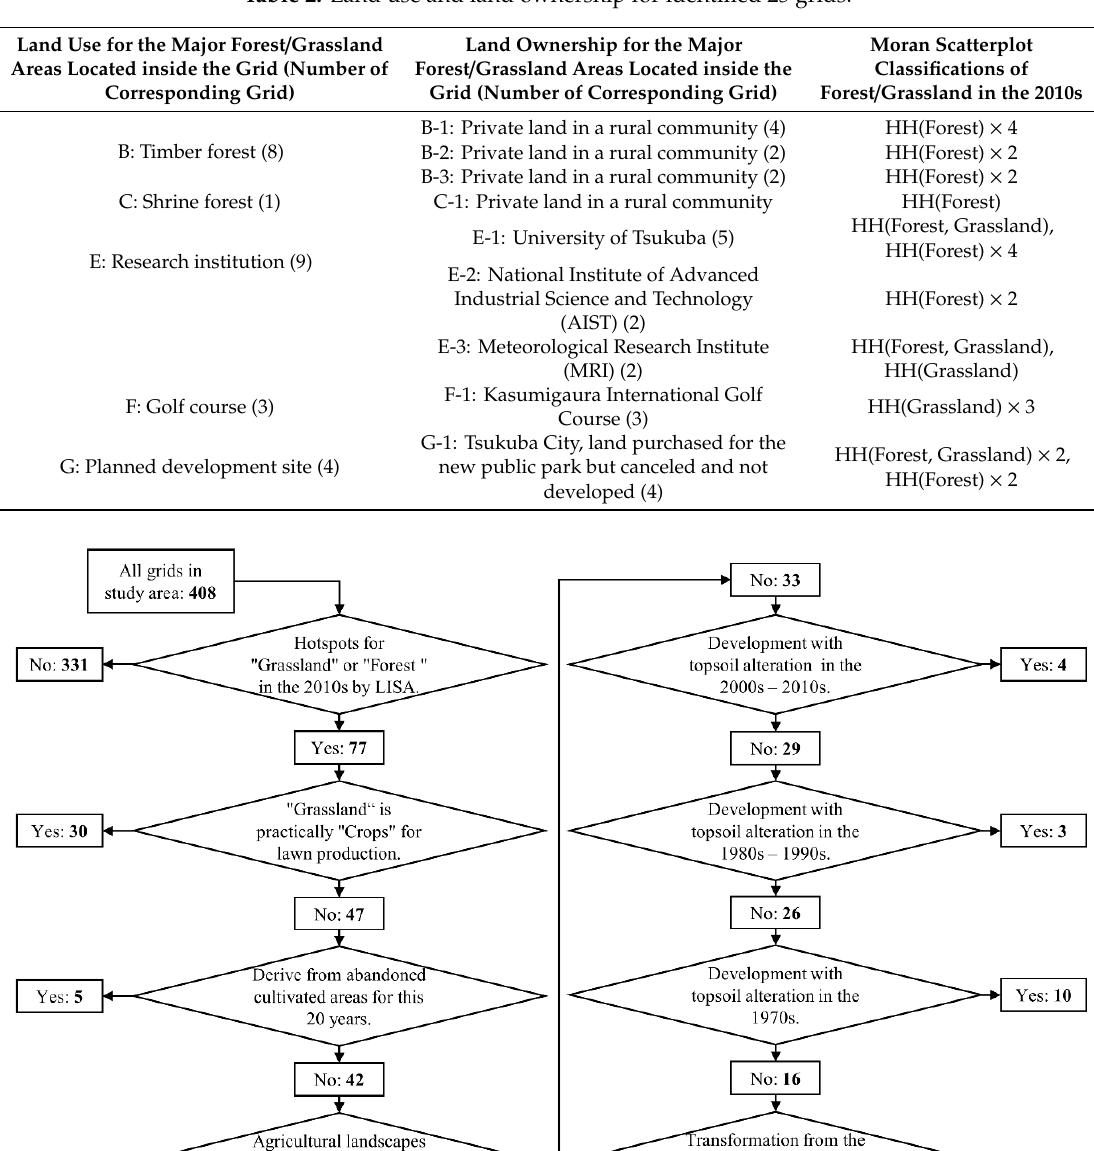
Table 2. Land use and land ownership for identified 25 grids.